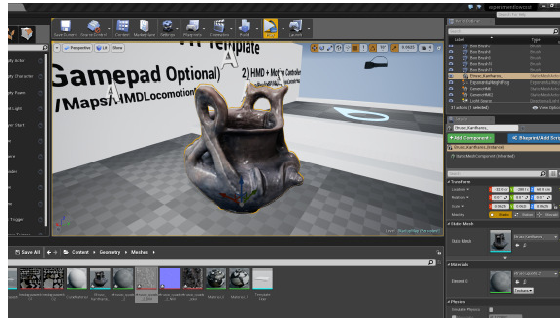
Figure 9. Virtual transfer on Unreal Engine 4.15 platform for immersive tour